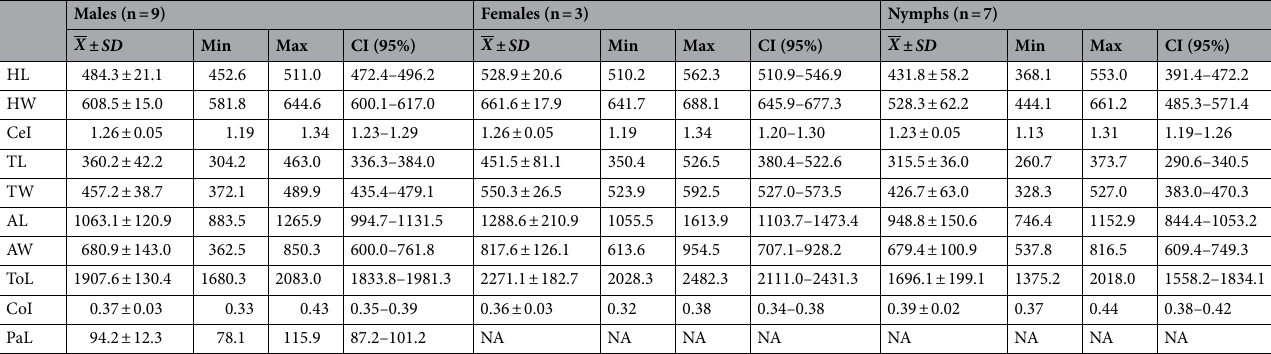
Table 2. Biometrical data obtained from the Degeeriella punctifer specimens analysed in this study. HL: head length; HW: head width; CeI: cephalic index; TL: thoracic length; TW: thoracic width; AL: abdominal length; AW: abdominal width; ToL: total length; CoI: corporal index; PaL: parameres length. Measurements are shown in micrometers and expressed as the mean ( X ) ± standard deviation ( SD ), followed by the minimum (Min) and maximum (Max) values, and the confidence interval (CI) at 95%. n: number of specimens analysed. NA: not